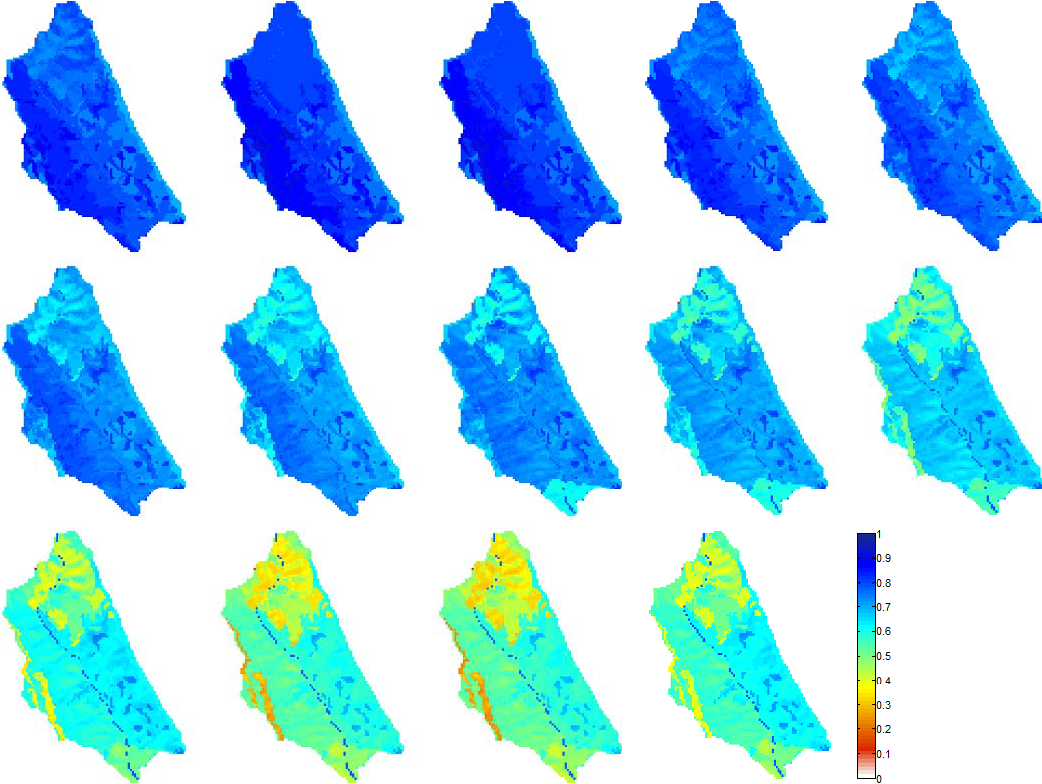
Fig. 3. Relative saturation degree maps obtained by the DREAM model for the days in which the field measurement have been carried out.